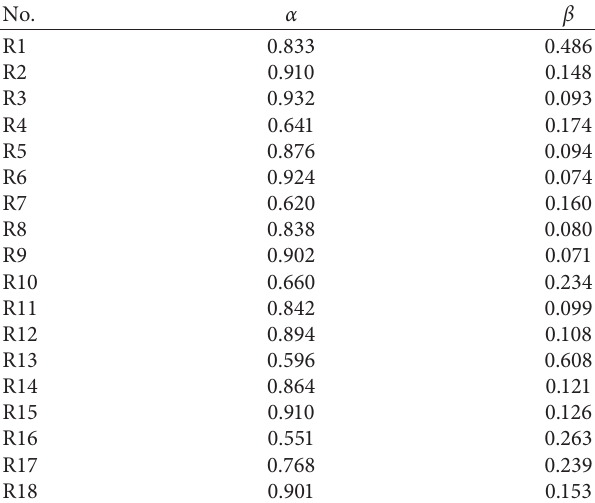
Figure 7: Damage model of the stiffness degradation index for the IHS. Table 2: The values of parameter α and parameter β for specimens R1 to